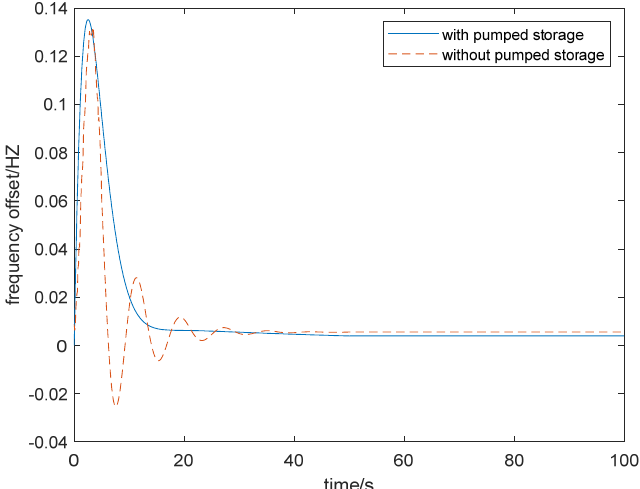
Figure 9. The frequency modulation difference curve of the unit when W = 0.5.